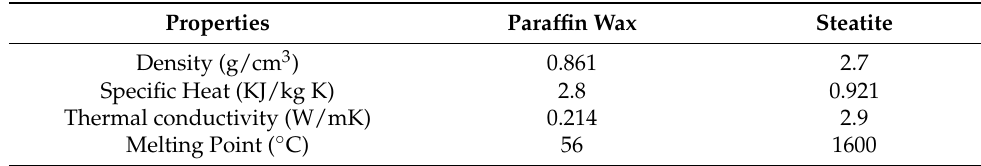
Table 1. Thermophysical properties of PCM materials.